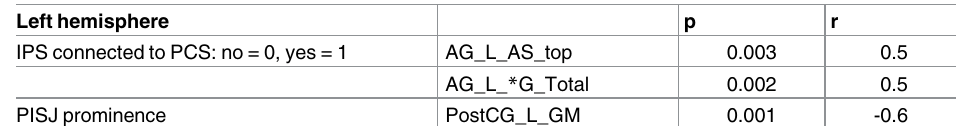
Table 7. Intrahemispheric correlation.